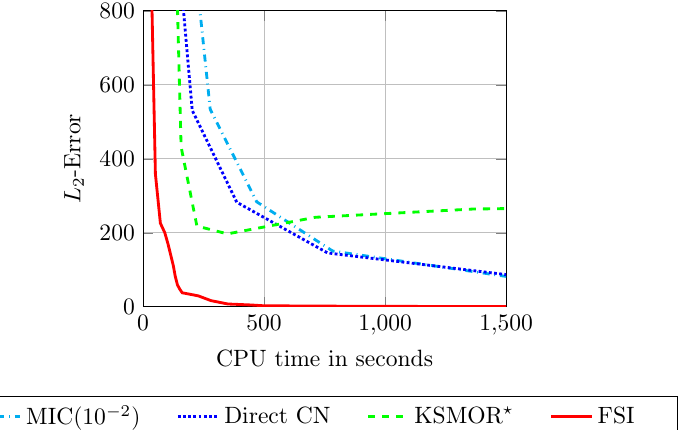
Figure A6. Results of the two-dimensional GES experiment without source: comparison of the L 2 -error and the corresponding CPU time between MIC(10 − 2 ), direct CN, KSMOR (cid:63) and FSI at t F = 2.609 10 6 for h = 0.01 ( N = 1,502,501 grid points). KSMOR (cid:63) is performed with q = 3 and × s = 20. The reference solution is computed with the EE method. The FSI method clearly outperforms all other methods even for finer grids.